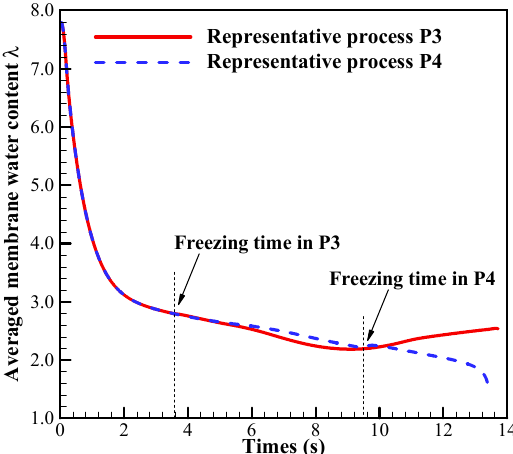
Figure 13. The evolution of the ACL volume-averaged membrane water content in process P3 and P4. The cell starts from − 20 ◦ C with initial membrane water content λ 0 = 7.8 and current density I 0 = 0.33 A/cm 2 . The cell is supplied with dry hydrogen and oxygen. The stoichiometry ratio of the mass flow rate is 2.0 for both anode and cathode sides. The background pressure is 1.0 atm at both the anode and cathode